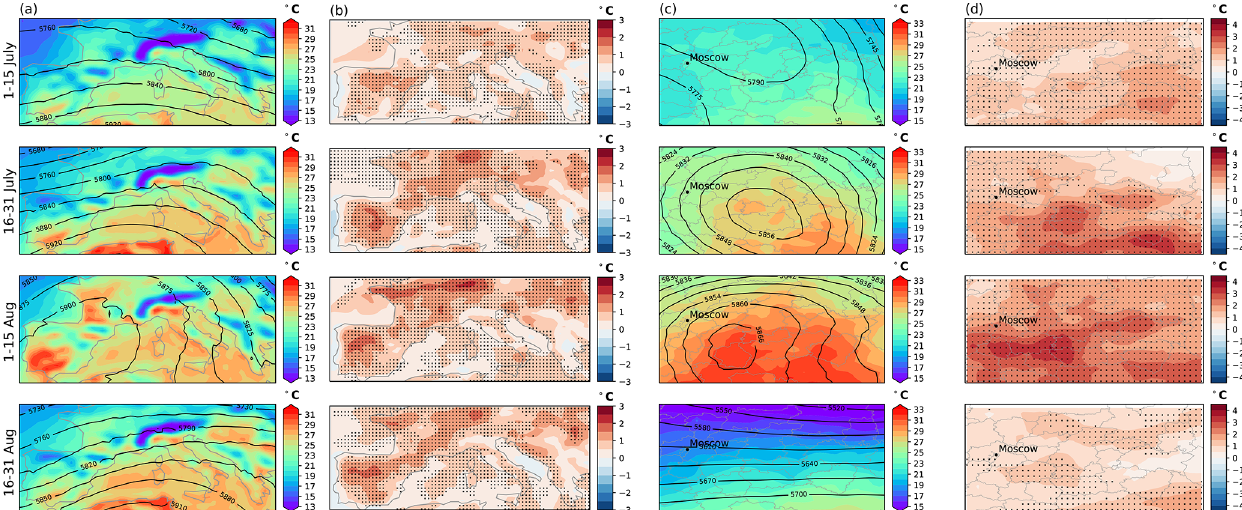
Figure 6. July and August divided into four half-month periods. Columns (a) and (b) show the European heatwave 2003, while columns (c) and (d) show the Russian heatwave 2010. In columns (a) and (c) , the factual geopotential height at z 500 [m] is shown as black contour lines, while temperatures at 2m height [ ◦ C] are shown as shaded fields. In columns (b) and (d) , the differences in 2m temperature [ ◦ C] between the factual and counterfactual simulations are shown as shaded fields. Stippling shows where all the factual members are > 0 . 1 ◦ C above all the counterfactual members for that grid point. Note that the Russian domain is smaller; therefore the stippling has a different spacing than in the European